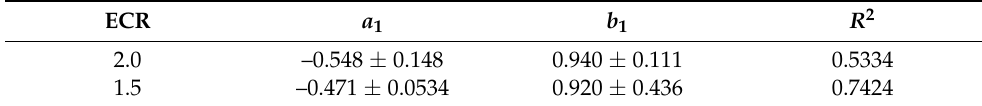
Figure 10. Relationship between the WMR value and total solid removal rate: □ represents the data from this work; ● and ■ represent the data from previous work [22]. Reproduced with per- mission from Pan, J.; Shao, J.; Qu, H.; Gong, X, ethanol precipitation of Codonopsis Radix concentrate with a membrane dispersion micromixer; published by J. Clean. Prod, 2020. Table 2. Linear fitting results for total solid removal rate and WMR.